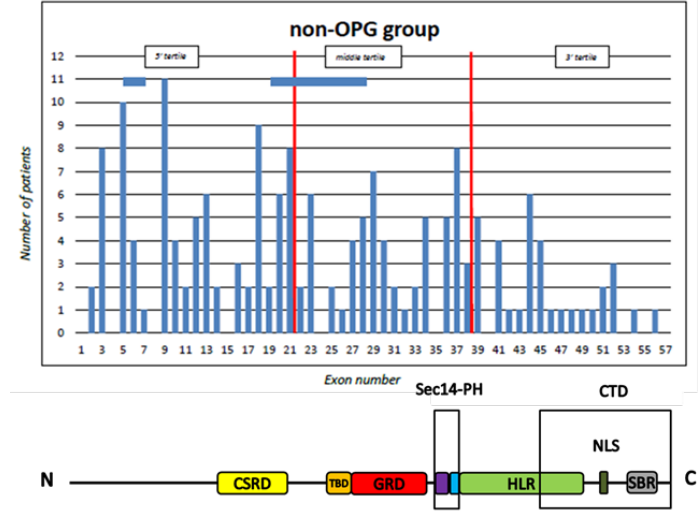
Figure 3. Distribution of NF1 gene mutations by tertile and domain in the non-OPG group. The horizontal bars indicate two OPG patients with a large deletion involving more than one exon. The vertical red lines indicate the limits of the tertiles.